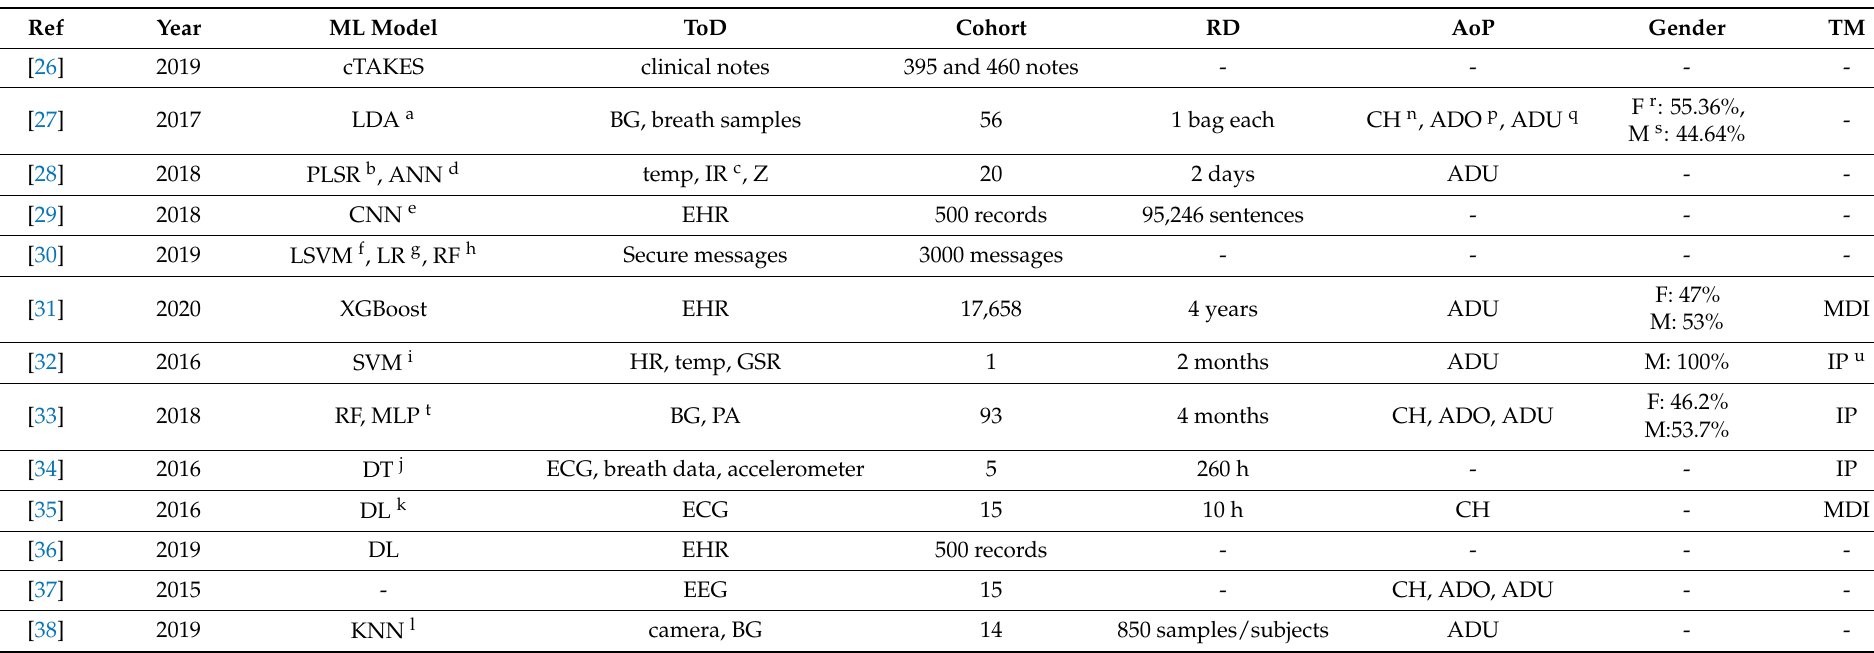
Table 1. Summary of reviewed manuscripts addressing hypoglycemia detection: ML model used to perform the detection, type of data (ToD) used to train the ML model, the size of the cohort, recording duration (RD), age of population (AoP), gender of the participants in study, treatment method